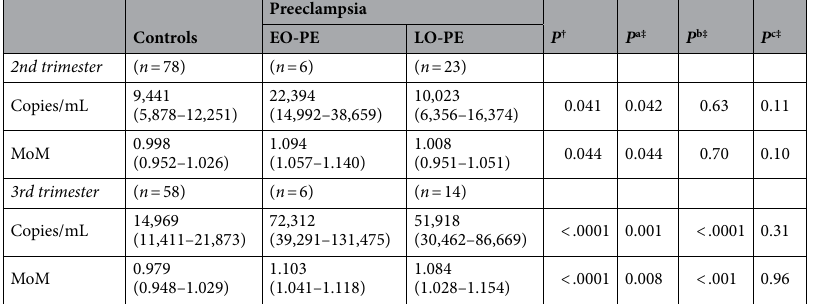
Table 3. Comparison of methylated HYP2 levels and MoM values between controls and patients with preeclampsia in terms of onset time of preeclampsia. Data are given as median (interquartile range). P a , EO-PE versus controls; P b , LO-PE versus controls; P c , EO-PE versus LO-PE. EO-PE early-onset preeclampsia, LO-PE late-onset preeclampsia, MoM multiple of the median. † P value by the Kruskal–Wallis test. ‡ P value by the Wilcoxon rank sum test (adjusted by using the step-up Bonferroni method).